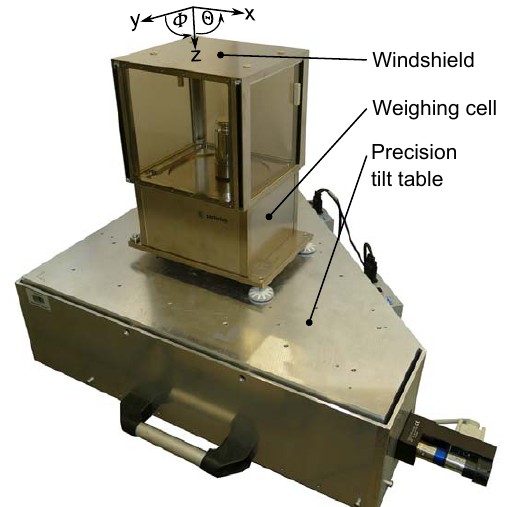
Figure 10. Experimental setup for the determination of tilt sensi- = h ∗ ≈ 0 . 359mm and T 2 T 3 tivities with the EMFC-weighing cell based on the mass comparator MCM1005.